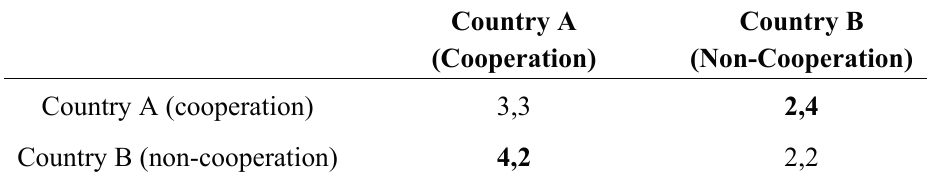
Table 2. Dilemmas of common aversion and divergent